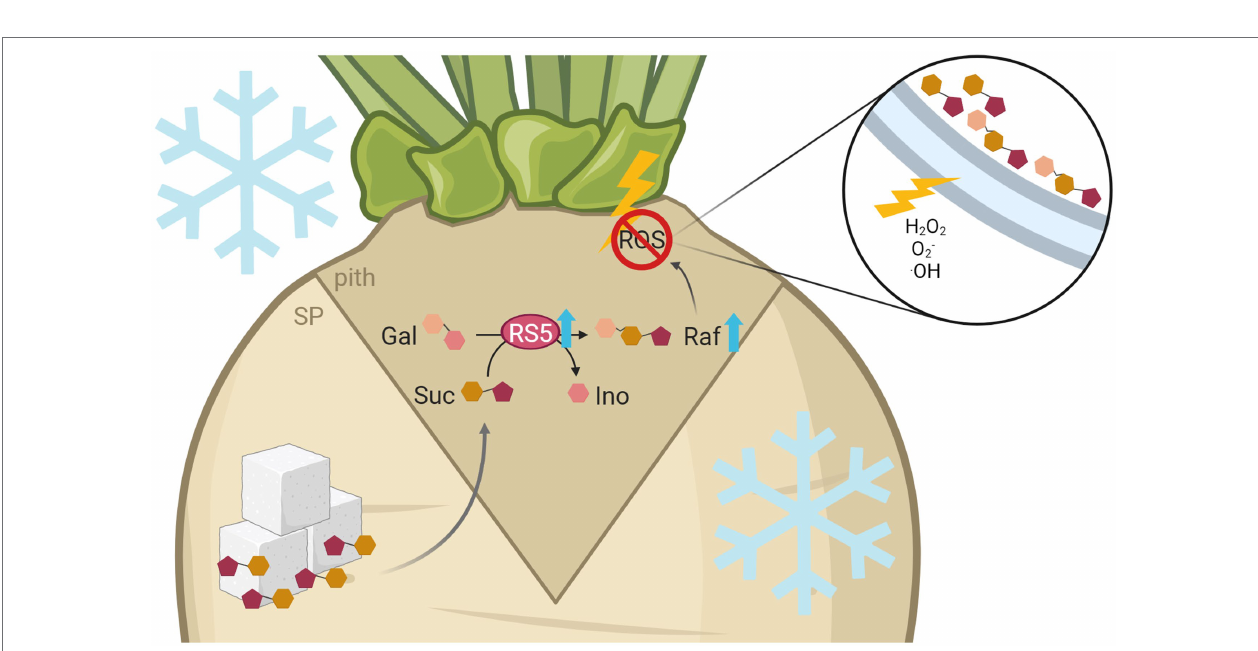
FIGURE 7 | Model of raffinose-mediated freezing tolerance in the sugar beet pith tissue. Freezing temperatures lead to increased expression of raffinose synthesizing enzymes, especially BvRS5 , in more tolerant cultivars. This results in higher raffinose contents in the pith. Frost exposition leads to high, damaging concentrations of H 2 O 2 , O 2 − , and ·OH especially in the pith tissue of sugar beet. There, high concentrations of ROS lead to damage of membranes by lipid peroxidation, which ultimately results in a structural collapse and therefore a brownish rot. Raffinose can protect the frost damage prone pith tissue against those harmful effects by a direct reaction with ROS. This figure was created with BioRender.com.